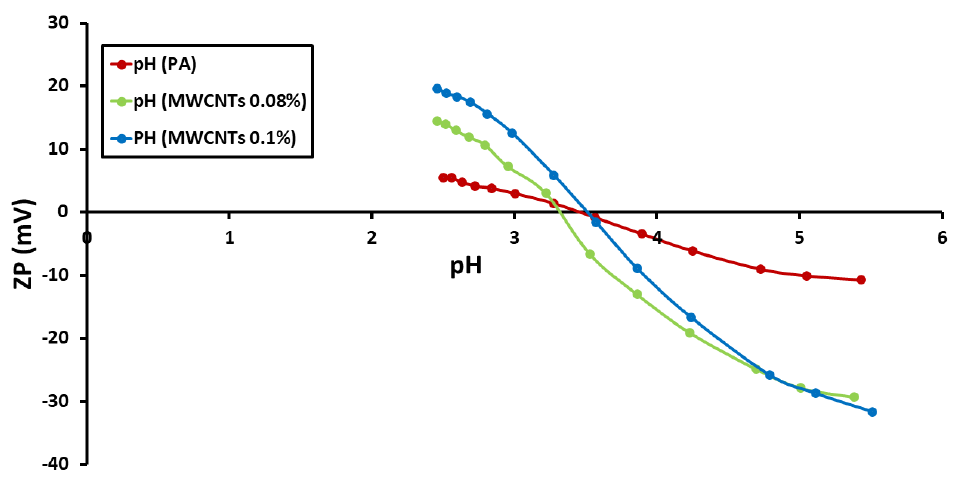
Figure 4. Zeta potentials of PA and PA-MWCNTs (0.08%, 0.1% and 0.15%) membranes as a function of pH.